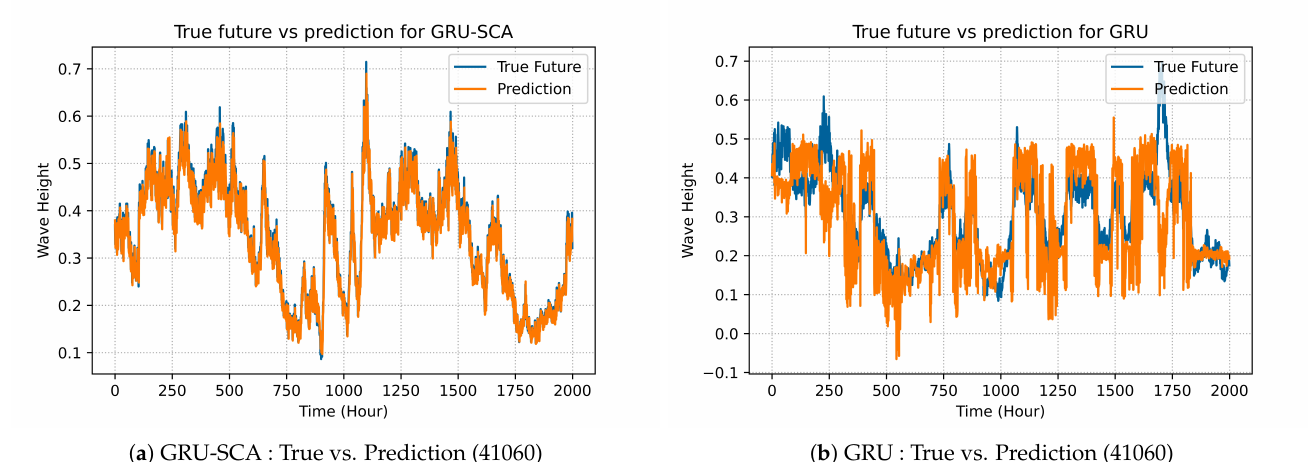
Figure 14. Comparison of GRU models on dataset 41060.